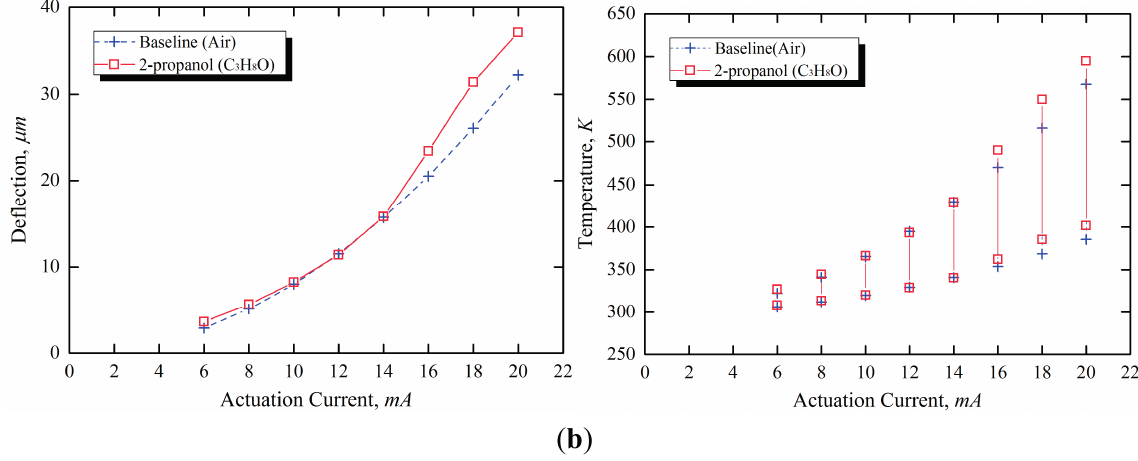
Figure 9. Simulation of the resultant deflection and temperature changes due to nano-scale combustion as a function of actuation current (from 6 mA to 20 mA at 2mA intervals)